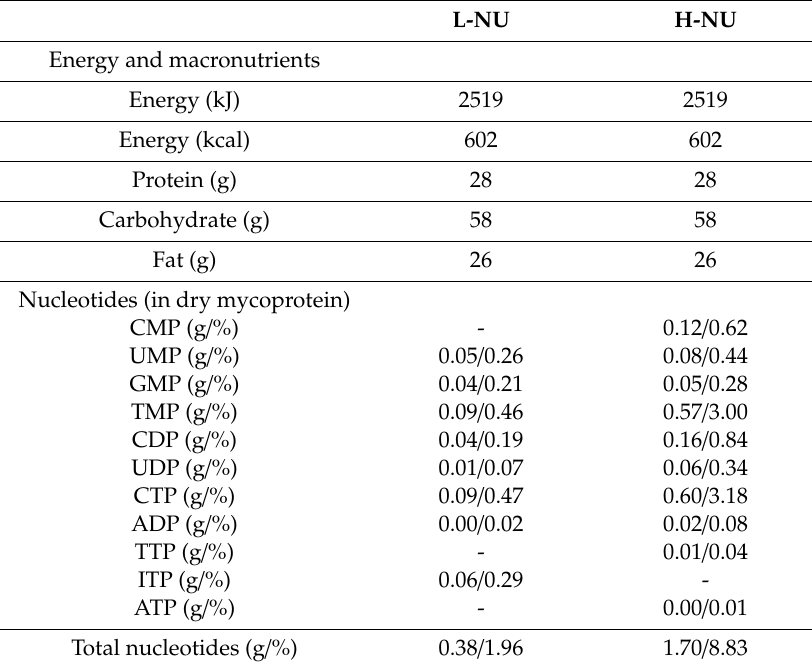
Table 2. Nutritional composition of the experimental